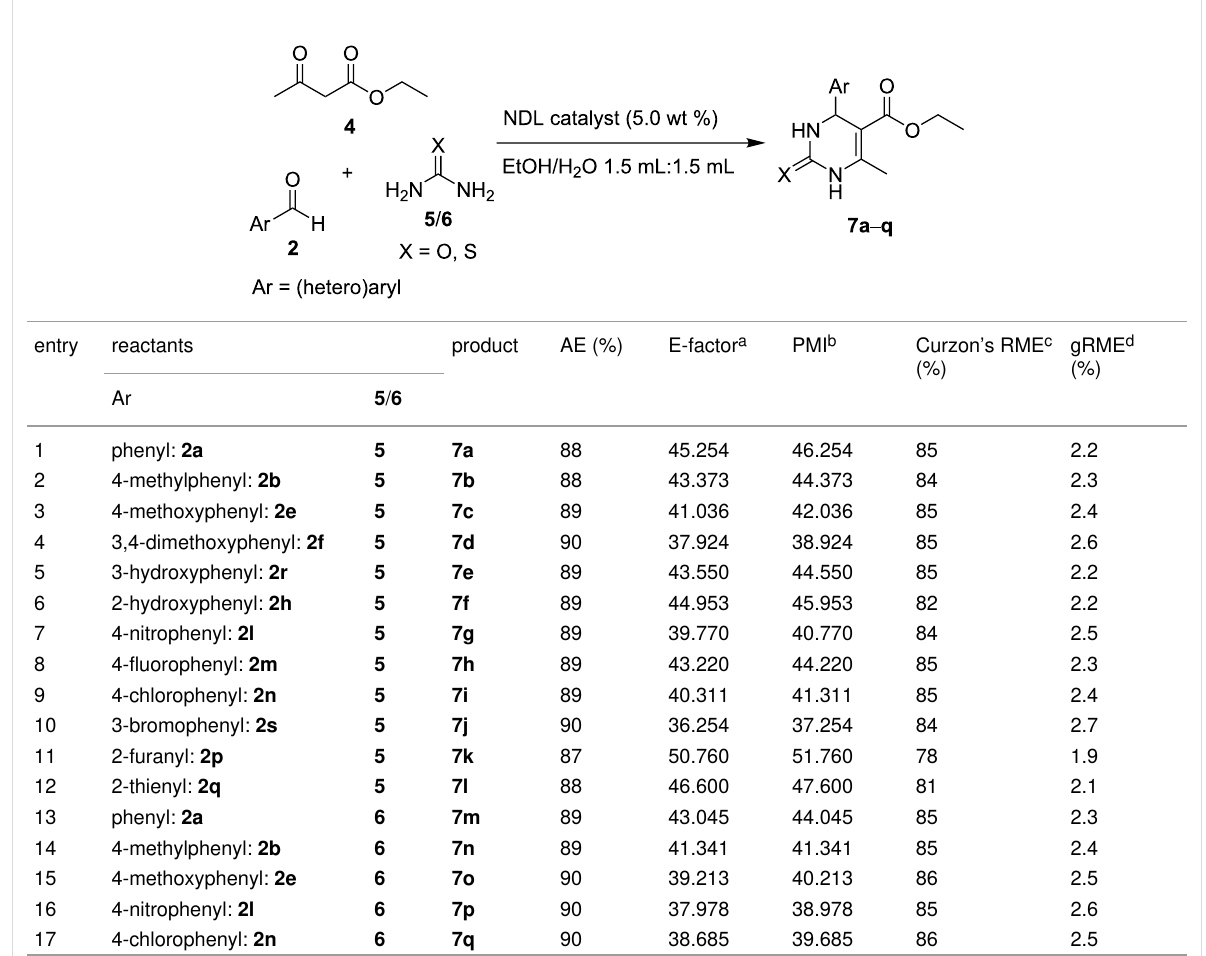
Table 9: Green chemistry metrics for the synthesis of dihydropyrimidinones/-thiones 7 .